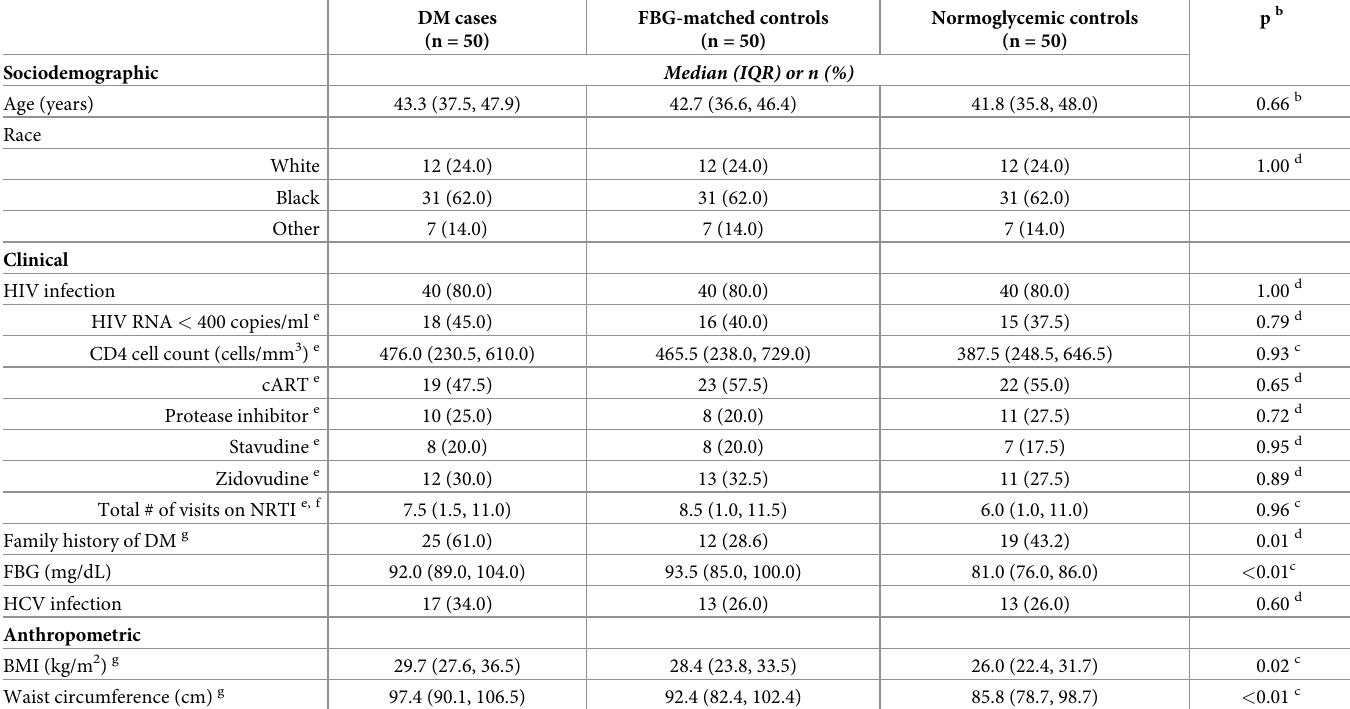
(Table 1). Comparing women with HIV infection across the three case-control groups, CD4 cell counts (p = 0.93) and the proportions of women with HIV RNA < 400 copies/mL (p = 0.79) were similar (Table 1). Percentages of women on combination antiretroviral therapy Table 1. Sociodemographic, clinical, and anthropometric indicators among WIHS participants a . DM cases (n =